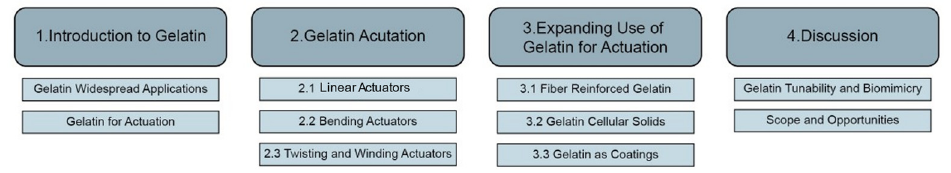
Figure 1. Overview schematic of gelatin actuators.